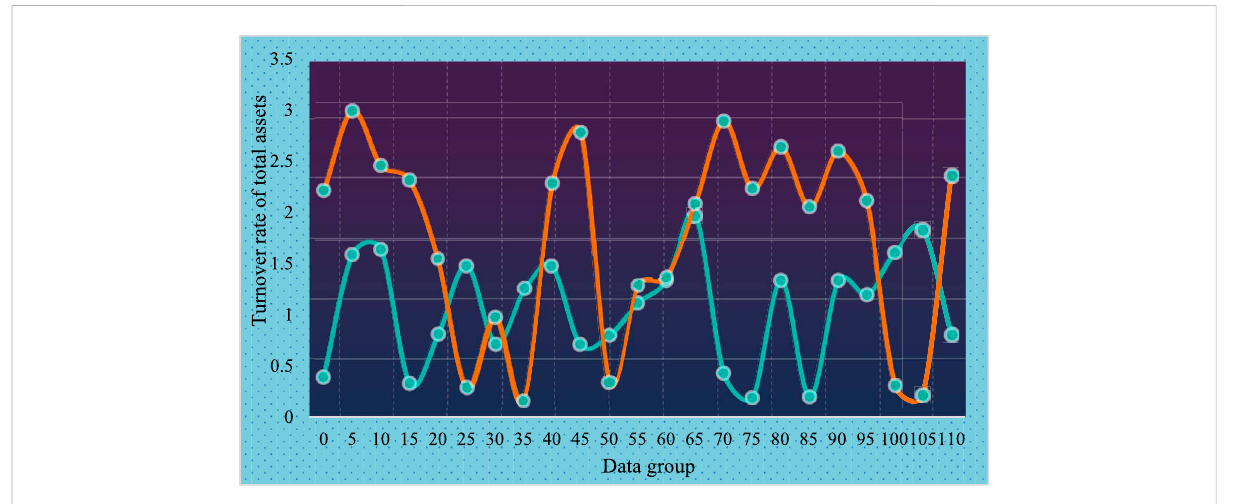
FIGURE 9 Training results of developmental ability